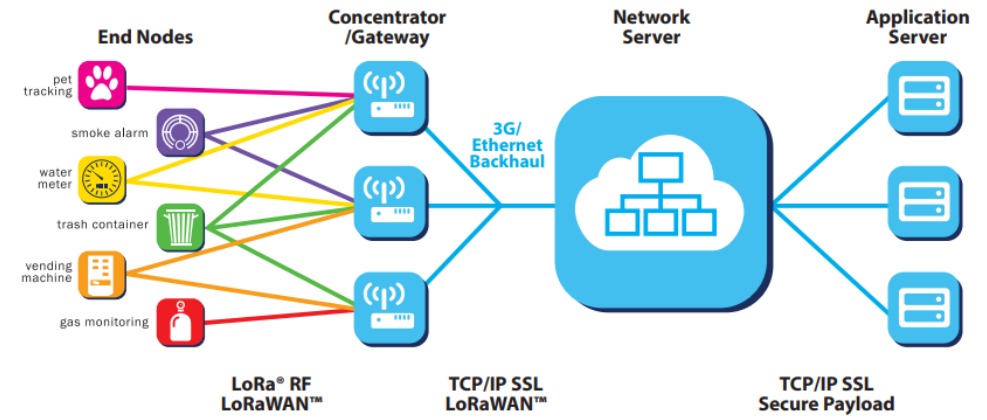
Figure 1. LoRaWAN architecture overview